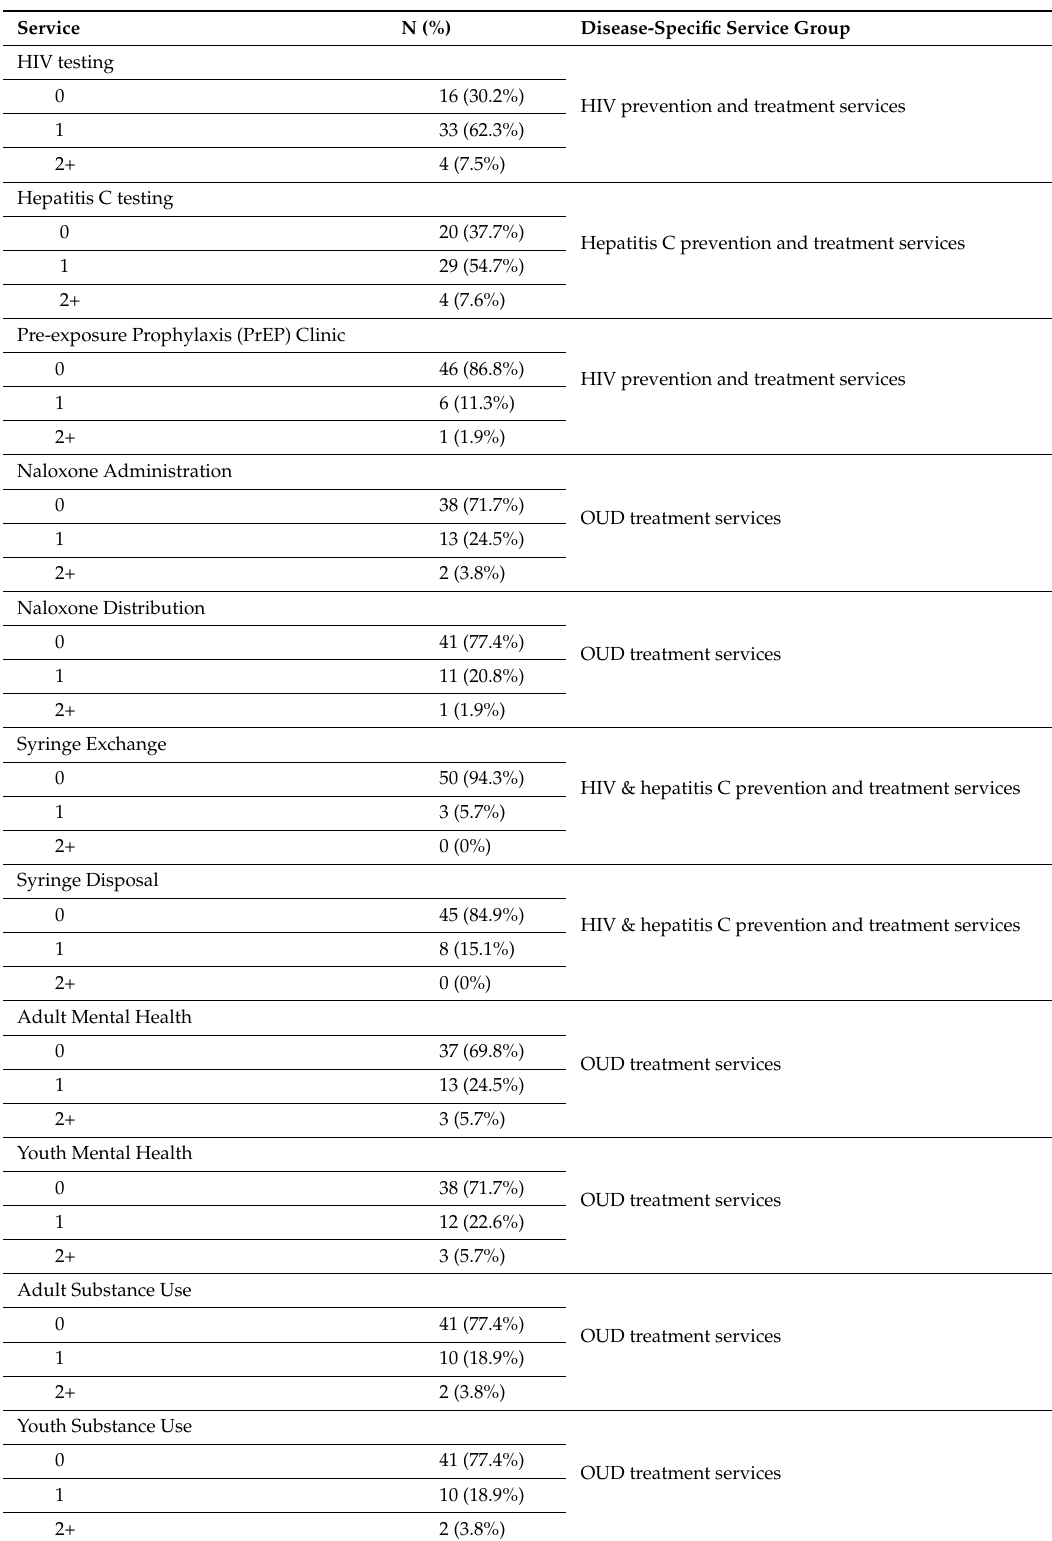
Table 1. Number of opioid use disorder (OUD), hepatitis C and human immunodeficiency virus (HIV) service locations reported by rural local health departments, Illinois,